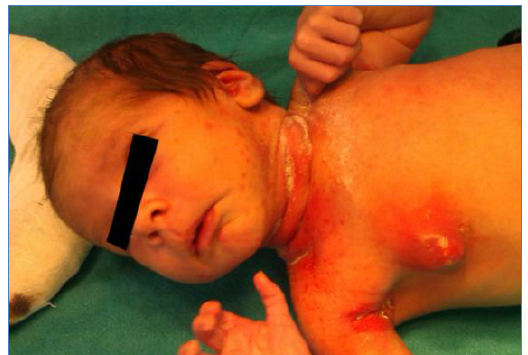
Figure 1: Neonatal breast abscess with extensive cervical and axillary